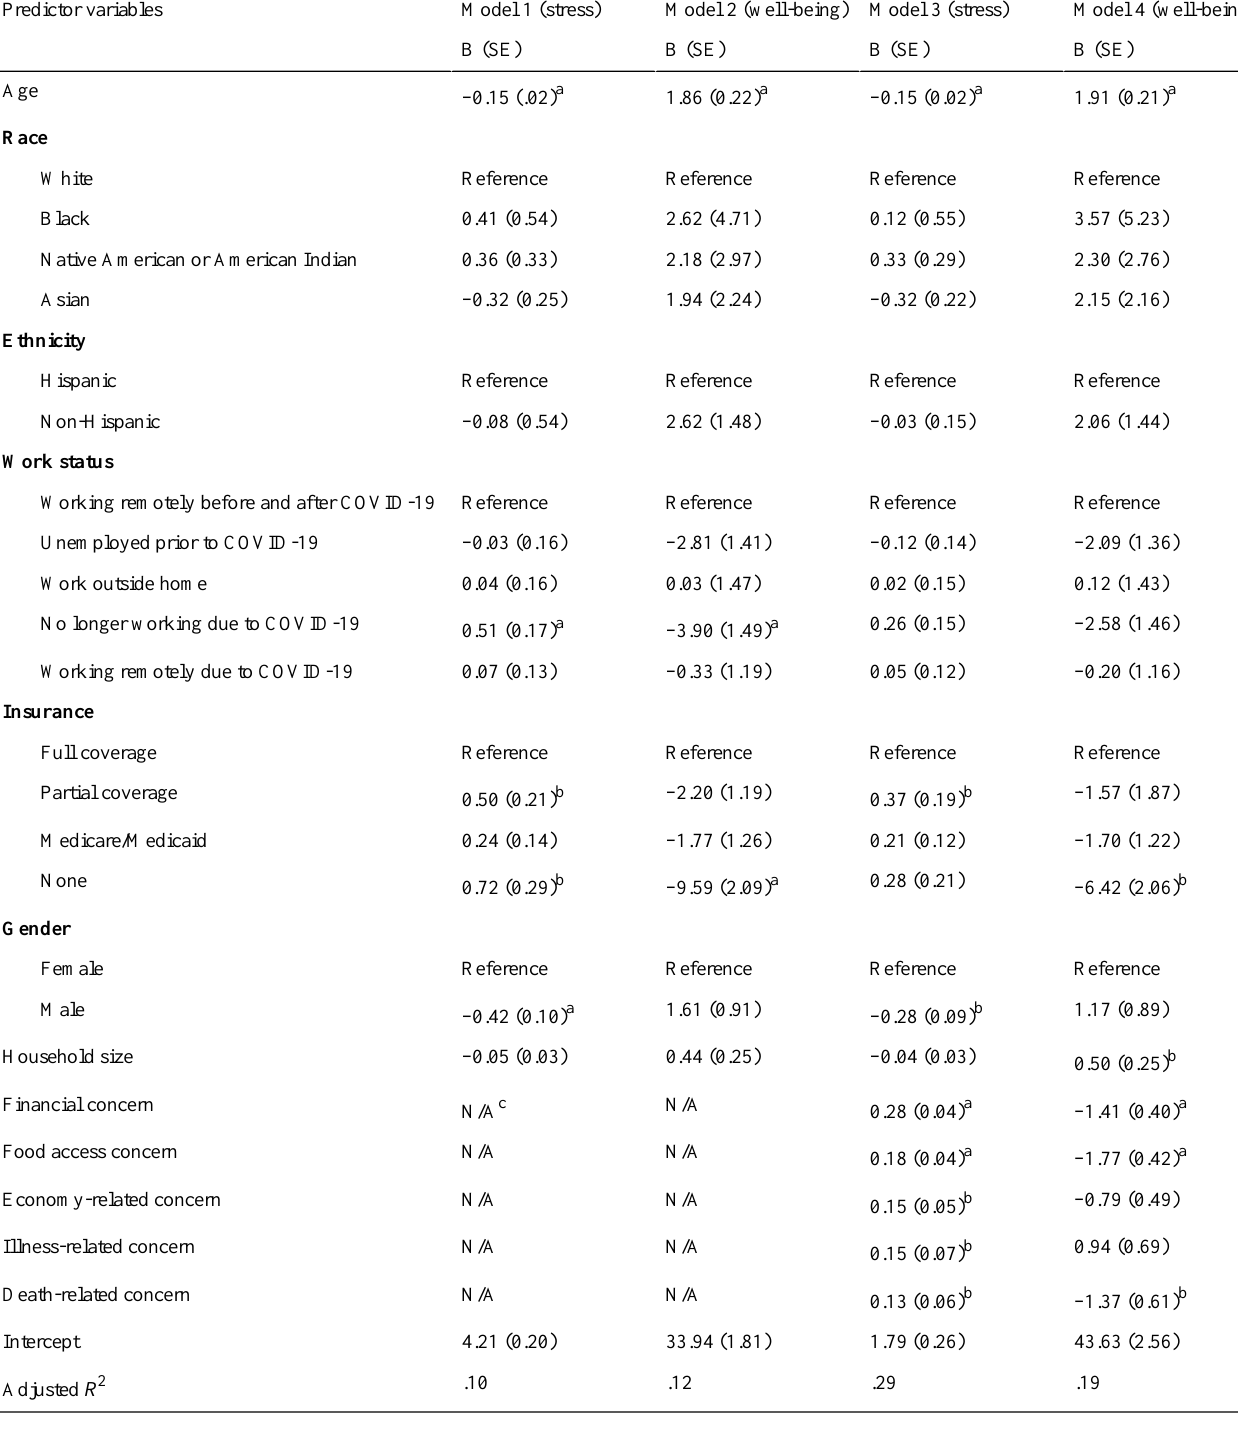
Table 3. Linear regression models showing associations between stress (Models 1 and 3), well-being (Models 2 and 4), demographic variables, and sources of concern